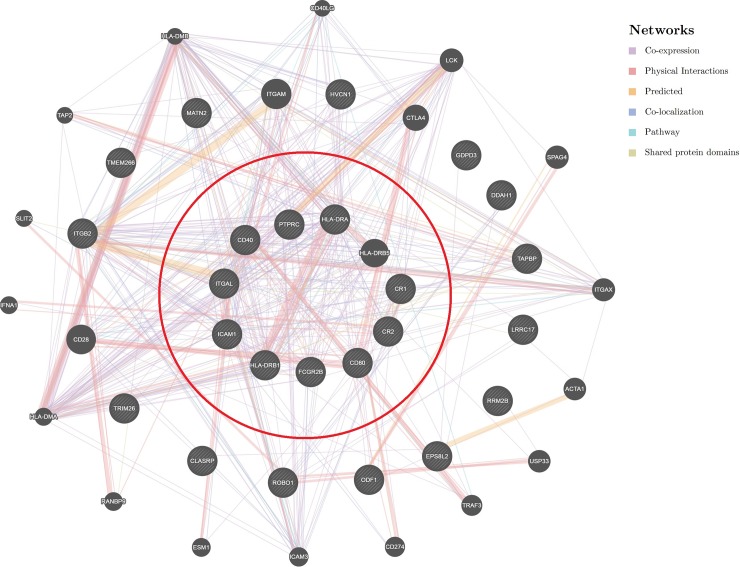
Network of gene-interactions the candidate genes (outside the red circle) and the “Biocarta B-lymphocyte pathway” (inside of the red circle).